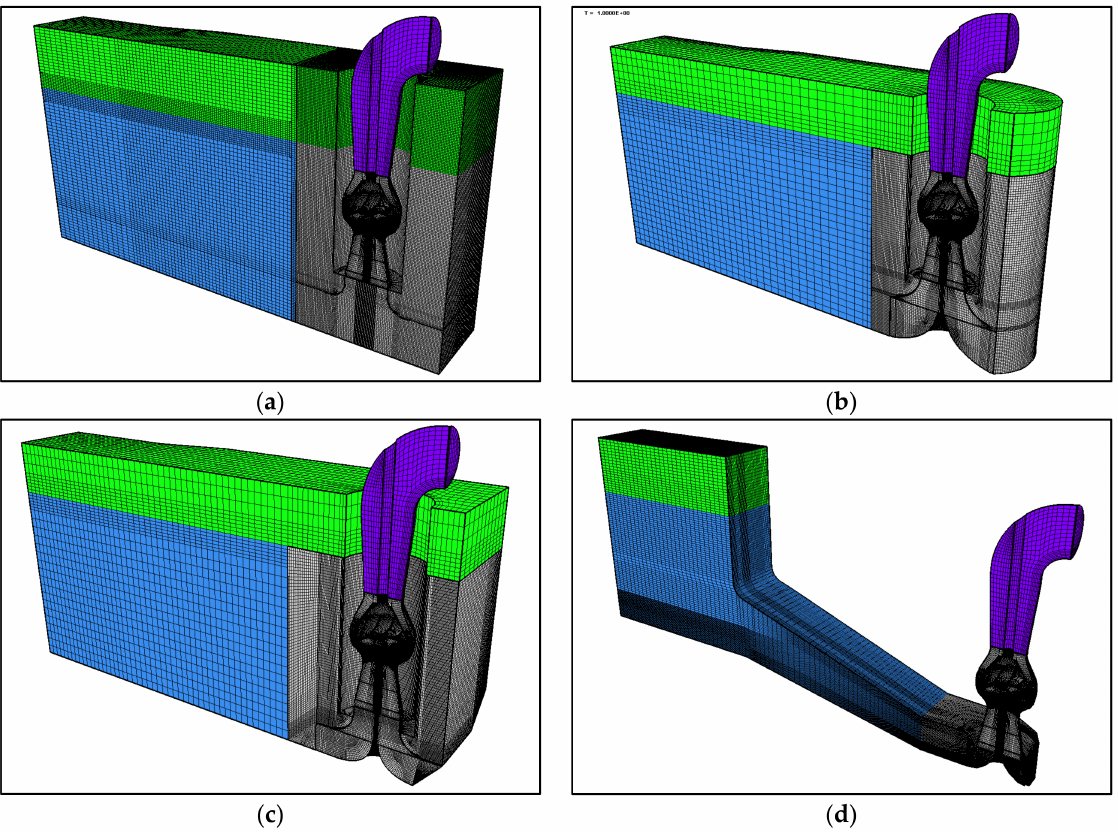
Figure 13. A cross-sectional view of meshed geometries for the 4 sump models: ( a ) Case 1, ( b ) Case 2, ( c ) Case 3, and ( d ) Case 4. Each model was separated into regions where high-density mesh count is created for regions with high velocity